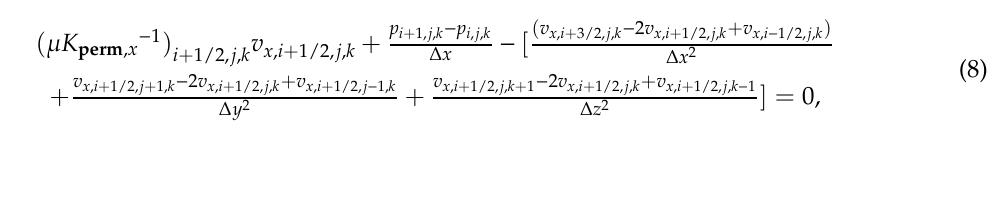
Figure 1. Definition of pressure, velocities, and concentrations on a grid with indices i , j , k. With the definitions of the pressure and velocities in Figure 1, the finite di ff erence approximations of Equations (1) and (2) in the 3D Cartesian coordinates system are given